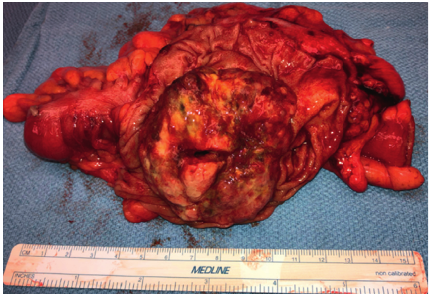
Figure 3: Gross pathologic specimen demonstrating a large